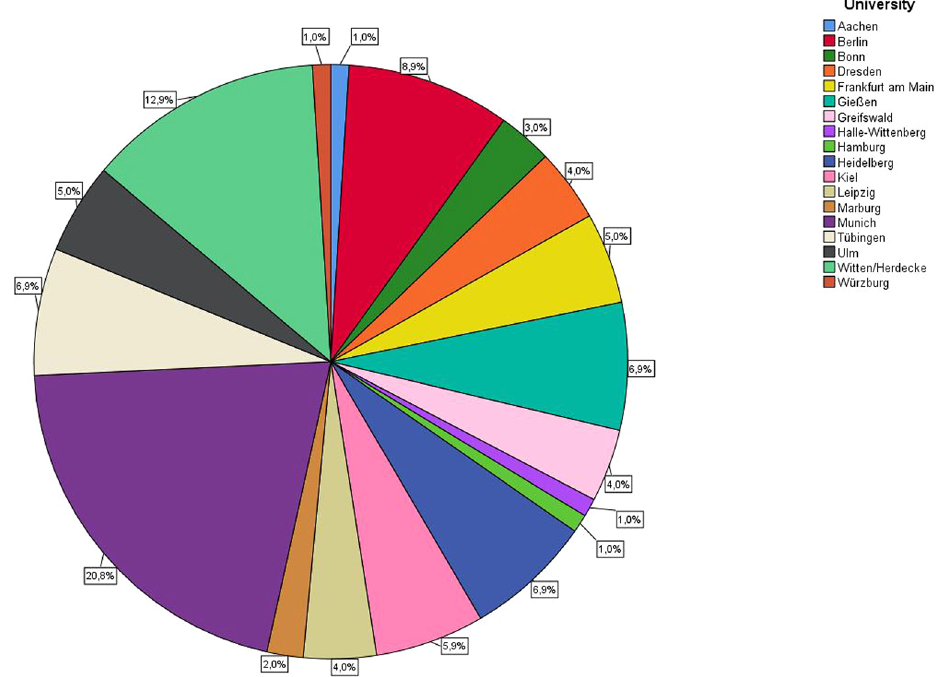
Figure 2. Overview of universities and distribution of participation in the online